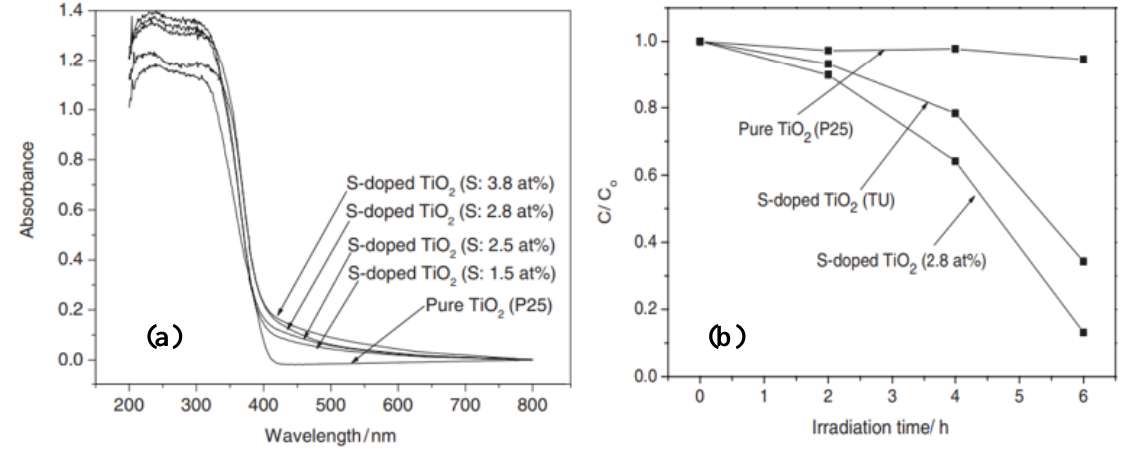
Figure 8. ( a ) Response of different concentrations of sulfur in S-doped TiO 2 ; ( b ) photocatalytic degradation of 4-chlorophenol by pure TiO 2 , SdT prepared by ThU and SdT by hydrothermal process studied via UV-vis [160].